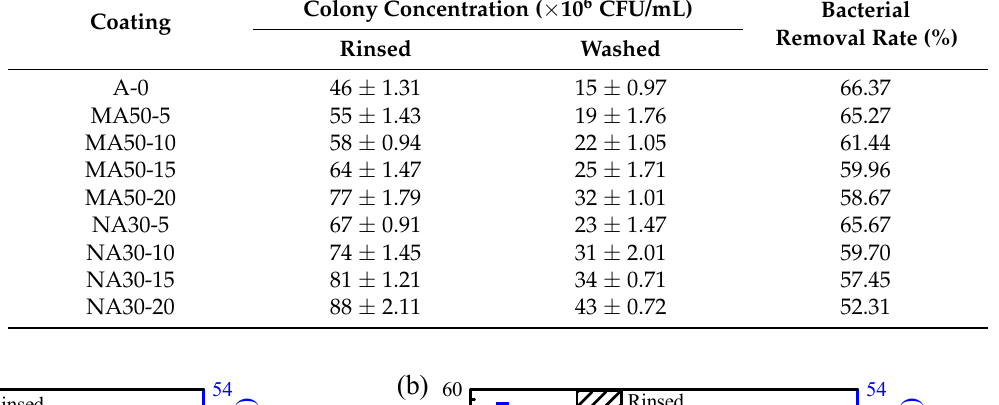
Table 5. Bacterial colony concentration and removal rate.